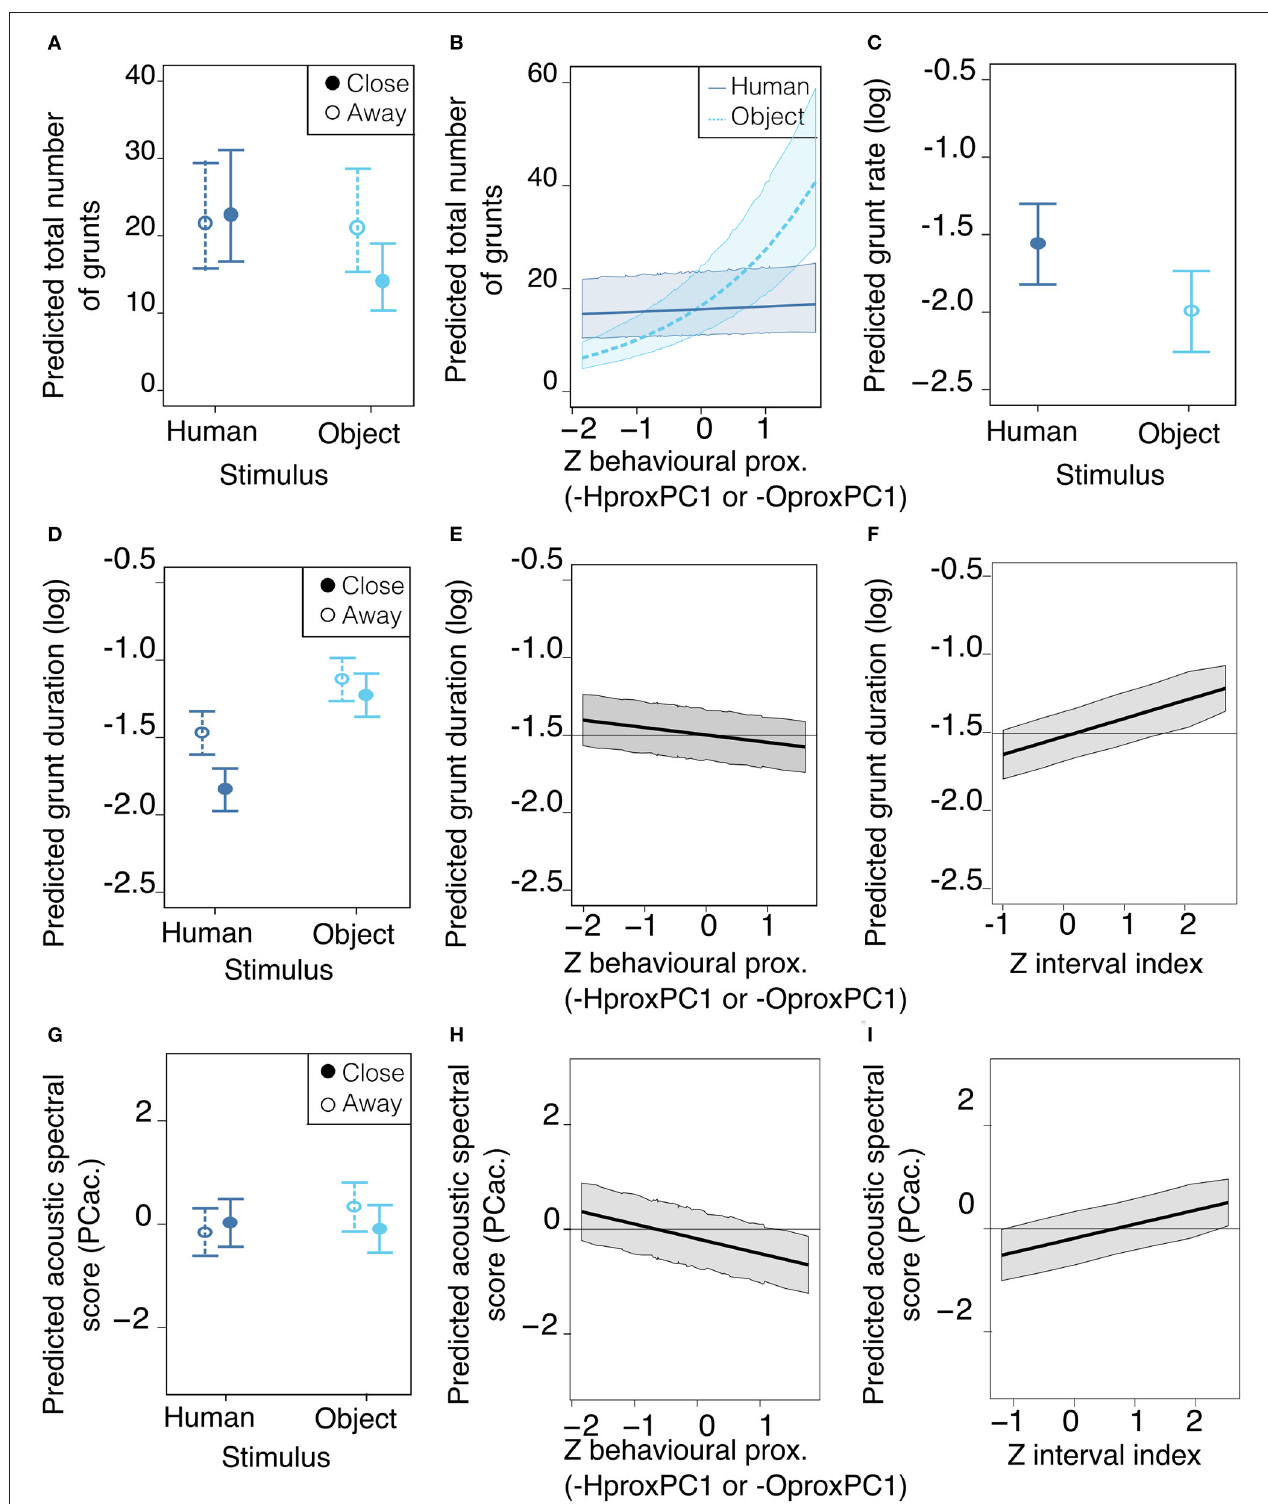
FIGURE 4 | Mean estimates and 95% confidence interval of best predictors of vocal expression: number of grunts (A,B) , grunt rate (C) , grunt duration (D–F) and acoustic spectral score PCac. (G–I) , depending on stimulus cyan for object, dark blue for human, location in the room, behavioral proximity and time during the test. Best predictors are represented for illustrating the range and directions of effects. Location (A,D,G) : whether the pig was located close to the stimulus (solid lines) or